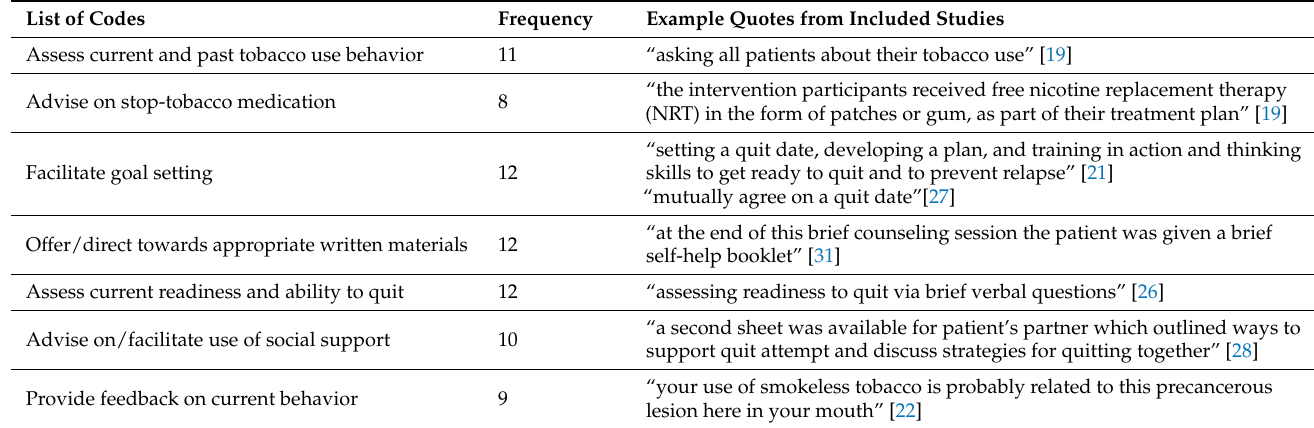
Table 3. Coding table of frequently identified behavior change